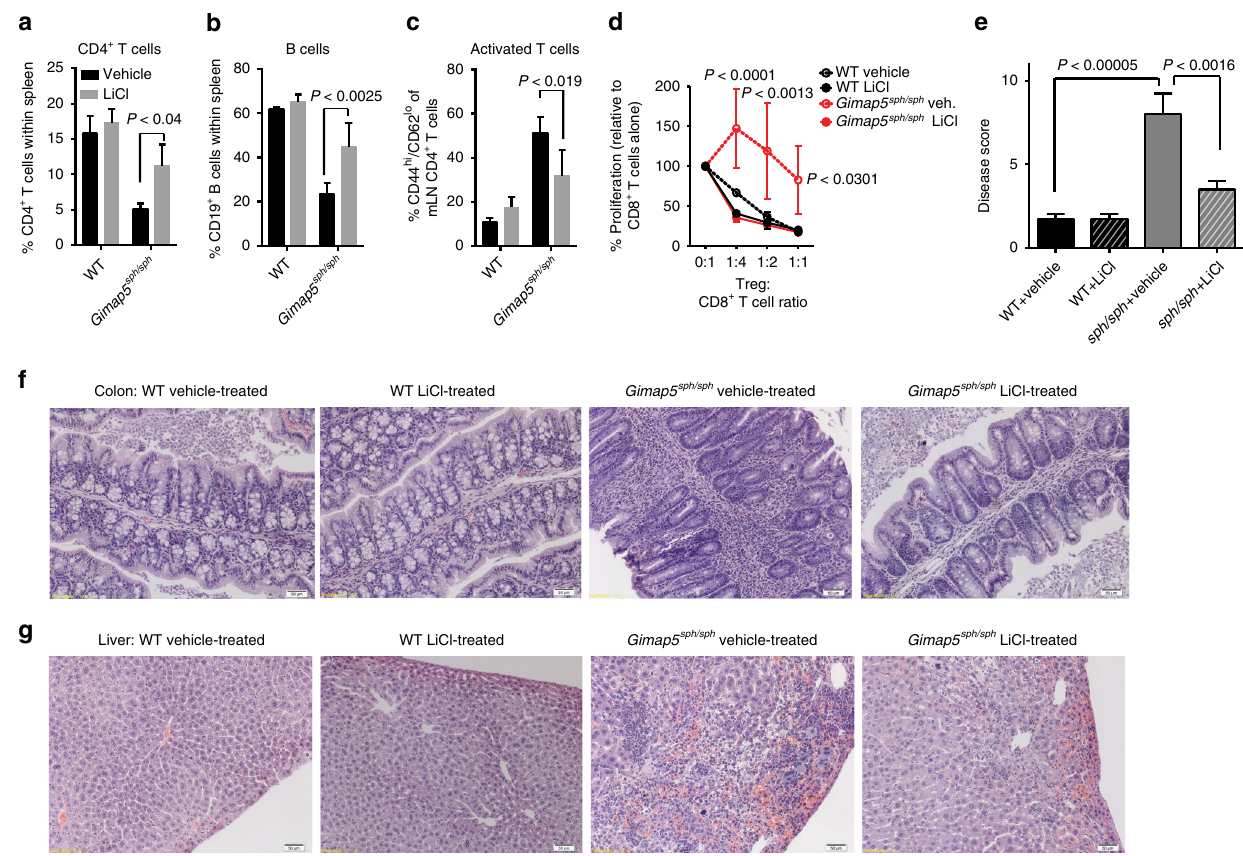
Fig. 5 GSK3 inhibition improves lymphocyte survival and prevents immunopathology. LiCl treatment of Gimap5 sph/sph mice in vivo starting at 3 weeks of age and analyzed at 7 – 8 weeks of age, rescues CD4 + T cell ( a ) and B cell ( b ) survival. c Reduced frequency of CD4 + T cells undergoing lymphopenia- induced proliferation (CD44 hi ;CD62 lo ) upon LiCl treatment of Gimap5 sph/sph mice in vivo. d Suppressive capacity of regulatory T cells (CD4 + CD25 hi ) isolated from vehicle or LiCl-treated WT and Gimap5 sph/sph mice. Data represents mean ± SD and is representative to two independent experiments ( n = 3). Reduced colitis as de fi ned by disease score ( e ) and based on colon histology ( f ) in 7 – 8-week-old Gimap5 sph/sph mice following LiCl treatment (3.5 weeks) in vivo. g Reduced liver pathology in Gimap5 sph/sph treated with LiCl. Data represent mean values ± SD from 6 mice per group at 7 – 8 weeks of age; histology is a representative depiction of disease severity. Scale bar is 50 μ m. Statistical signi fi cance is determined by ANOVA followed by Sidak ’